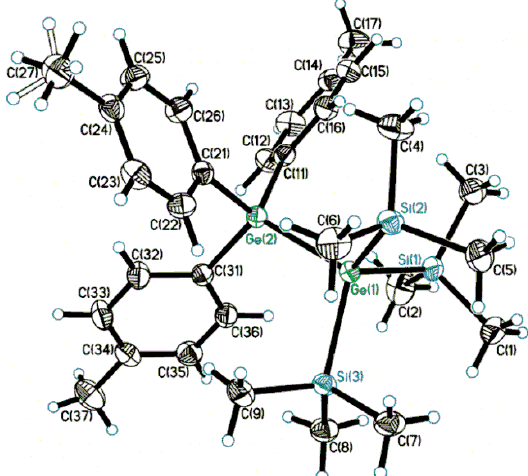
Figure 1. Molecular structure of compound (Me 3 Si) 3 Ge-Ge(C 6 H 4 Me -p ) 3 ( 1 ). Displacement ellipsoids are shown at a 50% probability level. Minor component of disordered Me group is drawn by open lines. Selected bond lengths (Å) and bond angles (deg): Ge(1)-Ge(2) 2.4393(2), Ge(1)-Si av 2.3864(4), Ge(2)-C av 1.9601(14); Si-Ge(1)-Si av 107.973(16), Si-Ge(1)-Ge(2) av 110.931(12), C-Ge(2)-C av 107.68(6), C-Ge(2)-Ge(1) av 111.21(4).